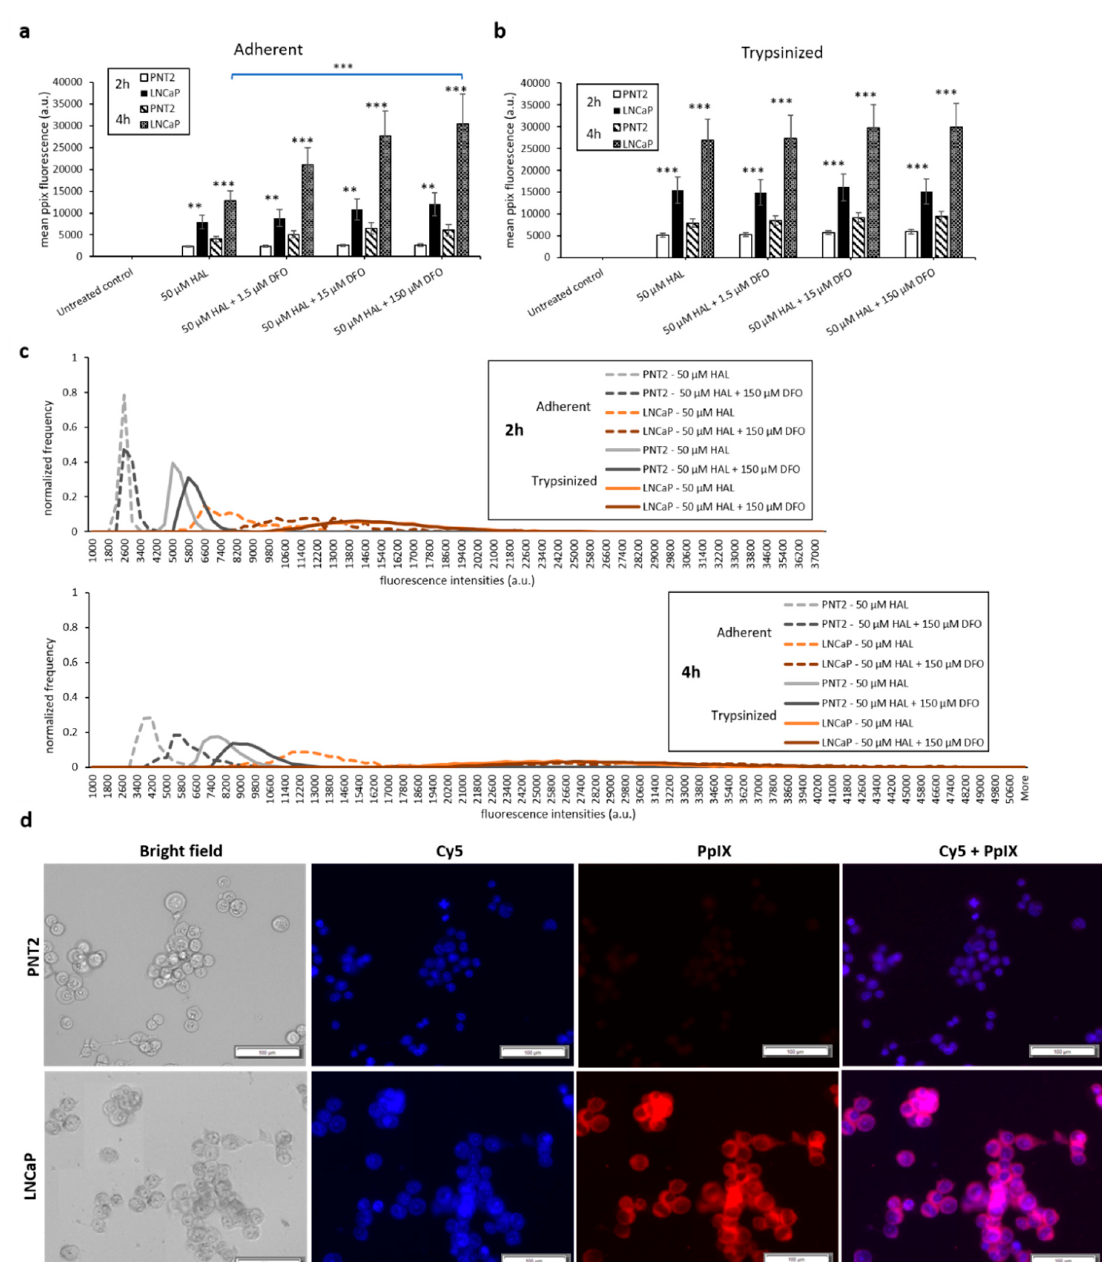
Figure 6. Effect of DFO and HAL treatment on PpIX fluorescence in human prostate cancer LNCaP and human prostate PNT2 cells. Cells were incubated with HAL (50 µM) alone or HAL (50 µM) and different concentrations of DFO (1.5 to 150 µM) in PBS for 2 and 4 h. Mean ± SD ( n = 3), statistical significance by ANOVA. ** p < 0.01 and *** p < 0.001 compared between prostate cancer LNCaP and prostate PNT2 cells in the same conditions. PpIX fluorescence was measured in adherent and trypsinised cells. Results are expressed in ( a and b ) bar and ( c ) histogram (50 µM HAL + 1.5/15 µM DFO not shown) graphs. ( d ) Microscopic images showing the PpIX fluorescence in adherent prostate cancer LNCaP cells after combined treatment with HAL and 150 µM DFO compared to prostate PNT2 cells (trypsinised cells images not shown). Scale bars represent 100 µm, magnification is 10X.